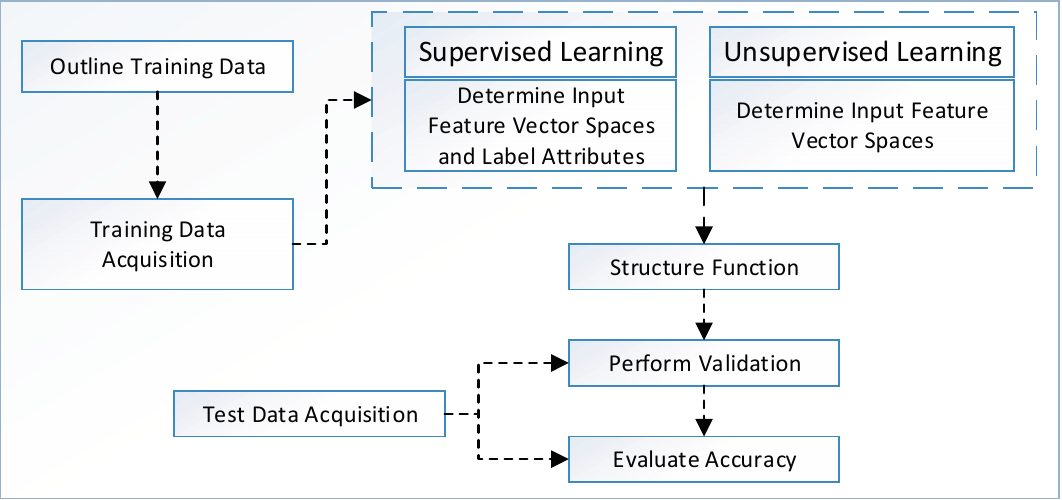
Figure 4. SL and UL algorithm development